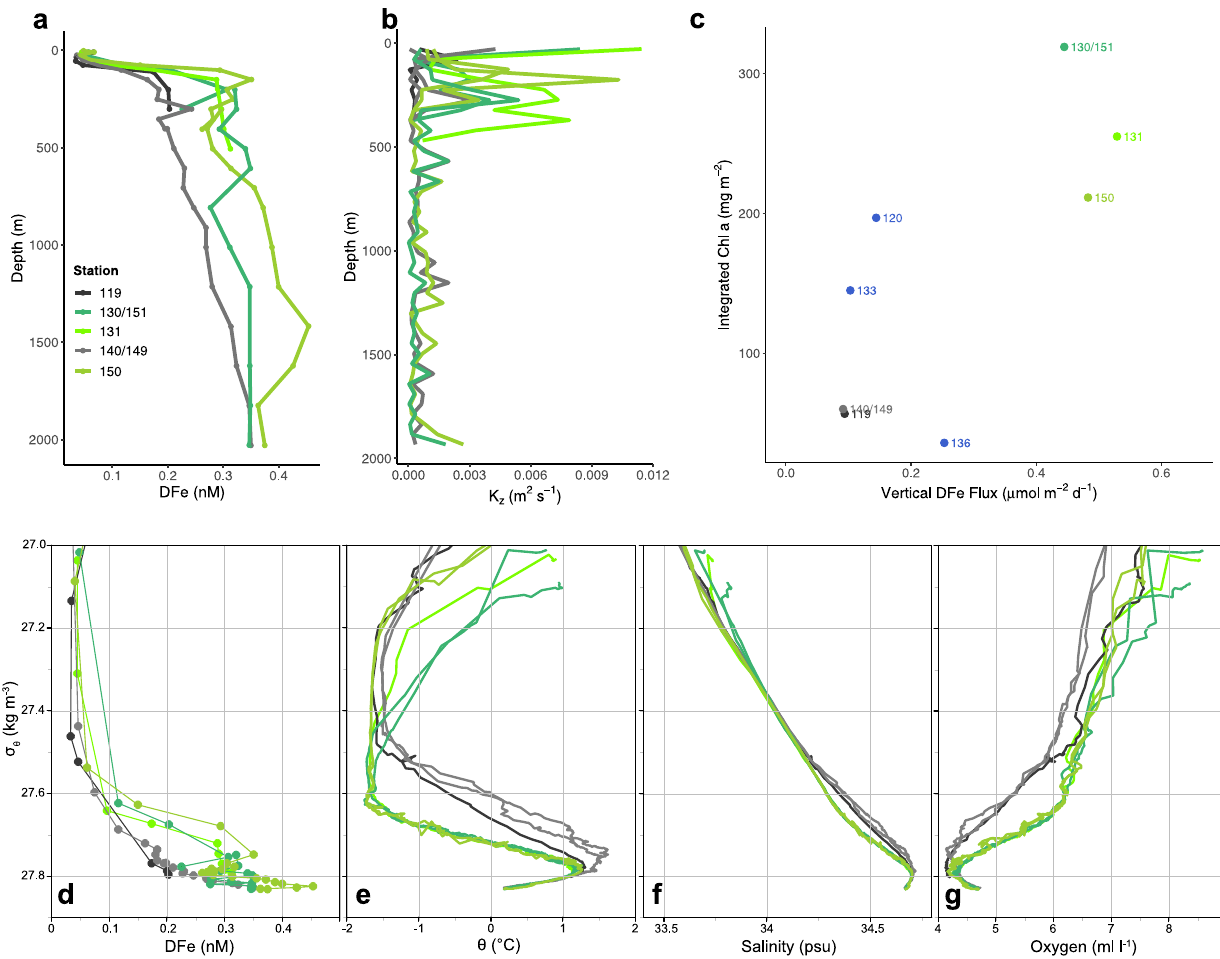
Fig. 3 Water mass characteristics in the bloom versus outside of the bloom. Depth pro fi les of a dissolved Fe (DFe) and b vertical diffusivity ( K z ) for stations inside the bloom (green lines) and stations outside the bloom (gray lines). c Depth-integrated chlorophyll a (Chl a ) versus DFe fl ux. Density pro fi les of d DFe, e potential temperature, f salinity, and g oxygen concentration. We do not include error bars for our DFe measurements or our depth- integrated Chl a measurements in either the depth or density pro fi les because the standard deviation for all DFe measurements was below 0.012 nM, and the error associated with all depth-integrated Chl a measurements was below 0.12%. Stations shown in blue c fall on the edge of the bloom and are not included in the other